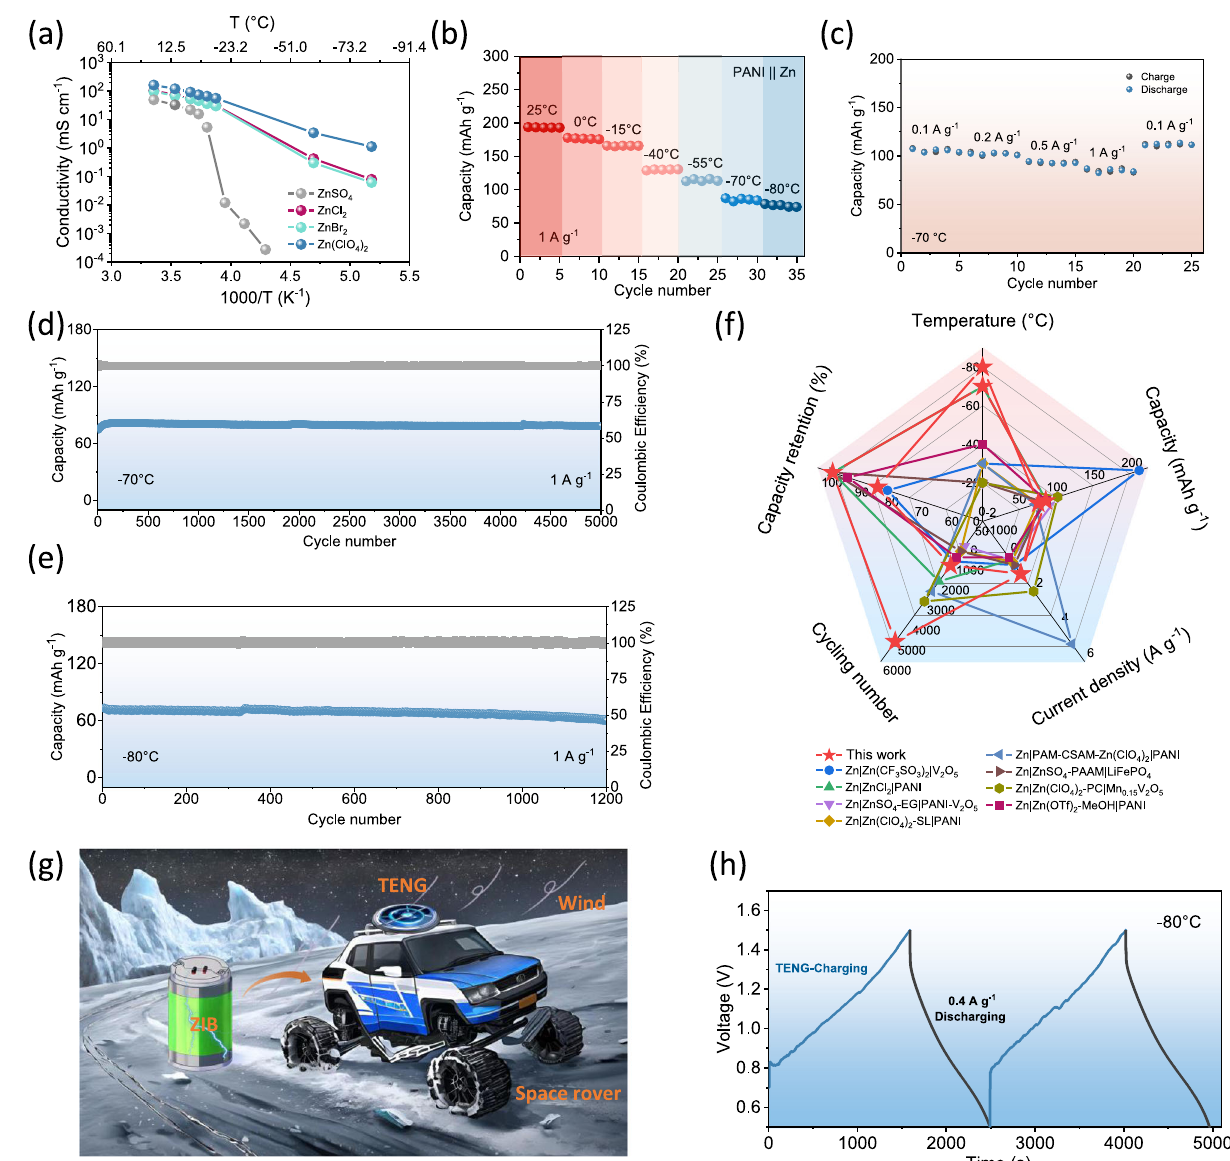
− 70°C. Cycling performance (1Ag − 1 ) at ( d ) − 70°C and ( e ) − 80°C. f Low- temperature performance comparison of this work with previously reported ZIB systems. g Schematic illustrating the self-powered system combining ZIB and TENGforpoweringaspaceroverunderextremelycoldconditions. h TENG-charge and galvanostatic discharge performance of the self-powered system at −